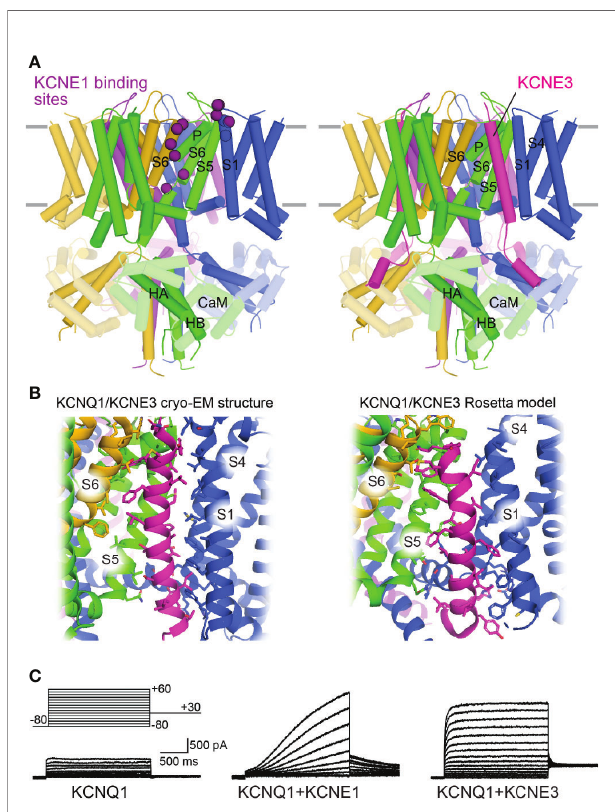
FIGURE 7 | Binding sites of KCNE proteins on the KCNQ1 channel. (A) Left: Mapping of putative KCNE binding sites onto the human KCNQ1 structure (PDB: 6V00) (Sun and Mackinnon, 2020). The position of residues identi fi ed to interact with KCNE1 (purple) are indicated by spheres. Right: Cryo-EM structure of human KCNQ1 with CaM and KCNE3 (PDB: 6v00)(Sun and Mackinnon, 2020). (B) KCNQ1/KCNE3 interaction sites. Left: 6V00. Right: KCNQ1/KCNE3 Rosetta model (Kroncke et al., 2016). Interactions sites were calculated with the InterResidues Python script in PYMOL (The PyMOL Molecular Graphics System, Version 2.2 Schrödinger, LLC.). Interaction positions indicated with sticks. (C) Example current traces of KCNQ1 alone or with KCNE proteins. Adapted with permission from (Van Horn et al.,